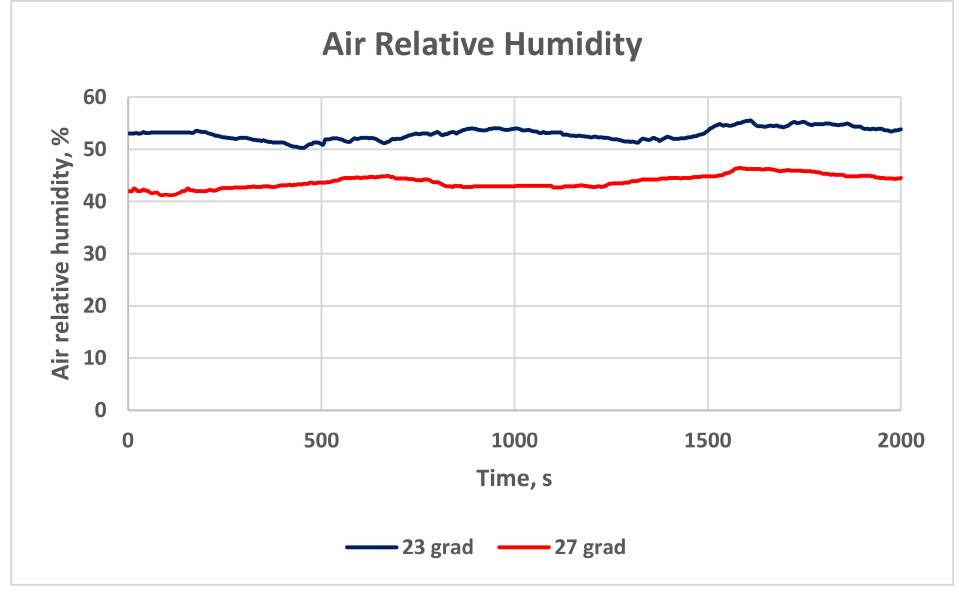
Figure 15. Relative humidity in the classroom during Stage 1 (27 ◦ C) and Stage 2 (23 ◦ C).